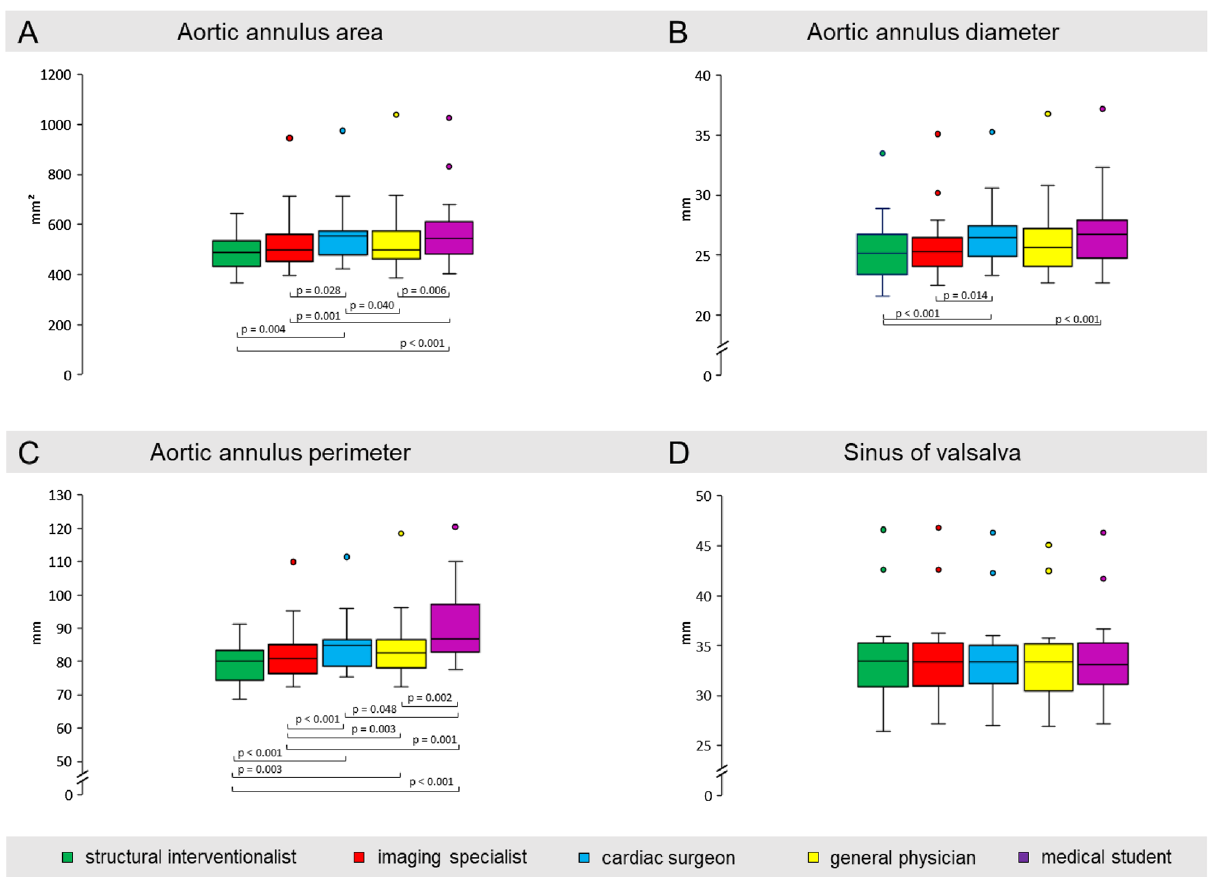
Figure 1. Inter-observer measurement presentations of ( A ) Aortic annulus area; ( B ) Aortic annulus average diameter; ( C ) Aortic annulus perimeter; ( D ) Sinus of Valsalva; p -values < 0.05 indicate significant